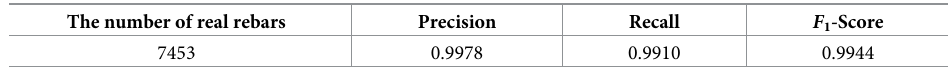
Table 3. The rebar counting results on test platform